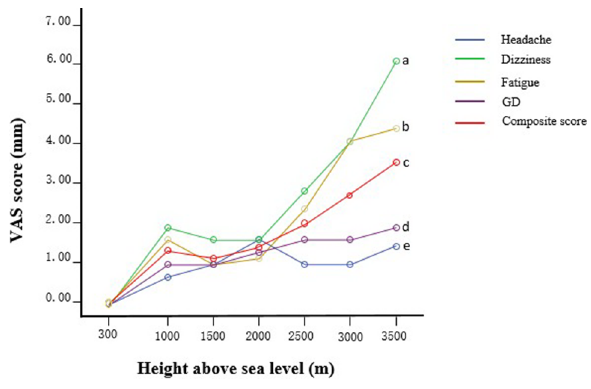
Figure 3. Repeated measure ANOVA between the altitude and VAS score. GD: Gastrointestinal discomfort. There was no correlation between headache and gastrointestinal discomfort with altitude ( e P . 0.05, d P . 0.05). Fatigue had a significant interaction with altitude ( b P , 0.05). The correlation between dizziness and the composite score with altitude was very significant ( a P , 0.01, c P , 0.01). 10 mm. A total of 5 subjects suffered dizziness at an altitude of 1000 m; 4 of them rated the dizziness at 10 mm and another at 20 mm. When the altitude increased to 3500 m, a total of 15 subjects had symptoms of dizziness; 4 rated the dizziness at